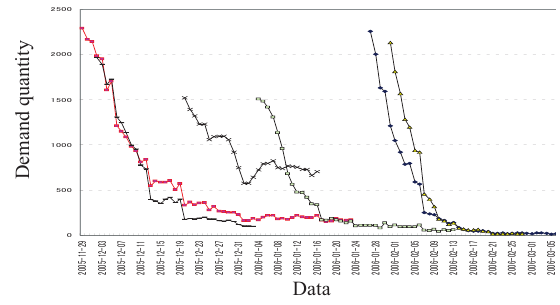
Fig. 1. Demand amount variation from sales release.